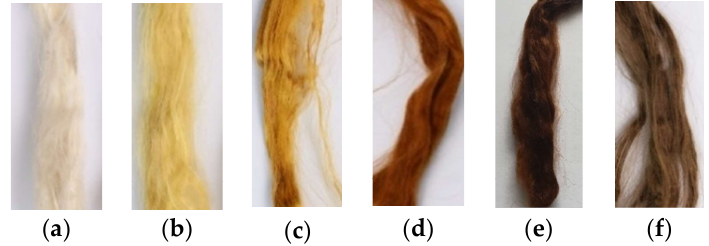
Figure 1. Photographs of cellulose fibers containing silver nanoparticles: ( a ) 0,01%, ( b ) 0,05%, ( c ) 0.1%, ( d ) 1%, ( e ) 3% synthesized in the presence of polyethyleneimine (PEI); ( f ) 0.1% synthesized without PEI.